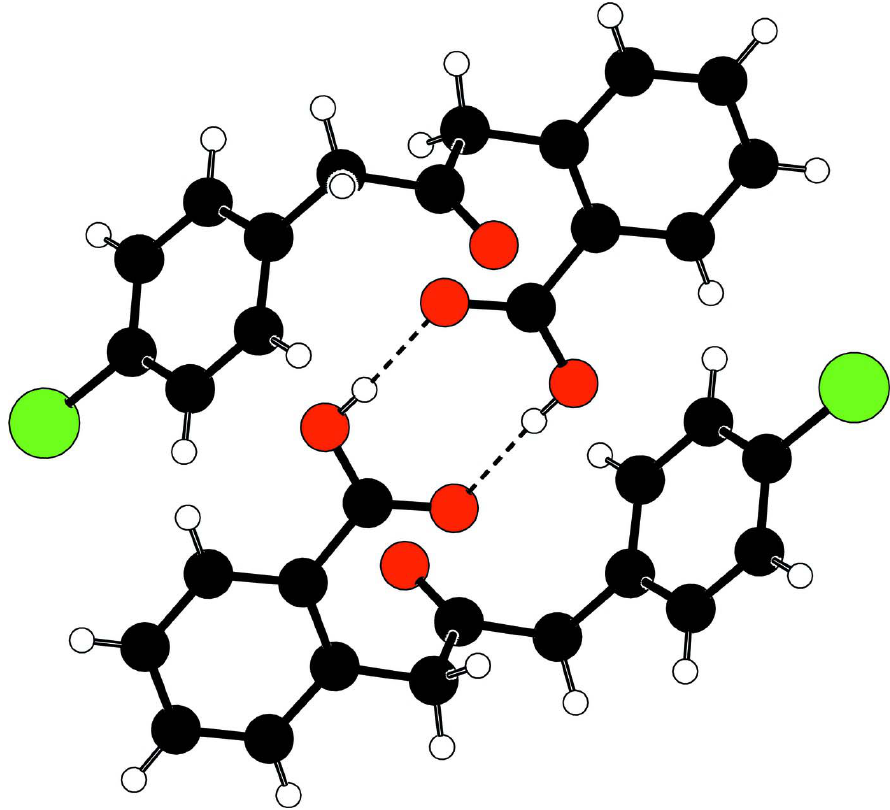
Figure 2 A partial packing diagram. Hydrogen bonds are shown as dashed